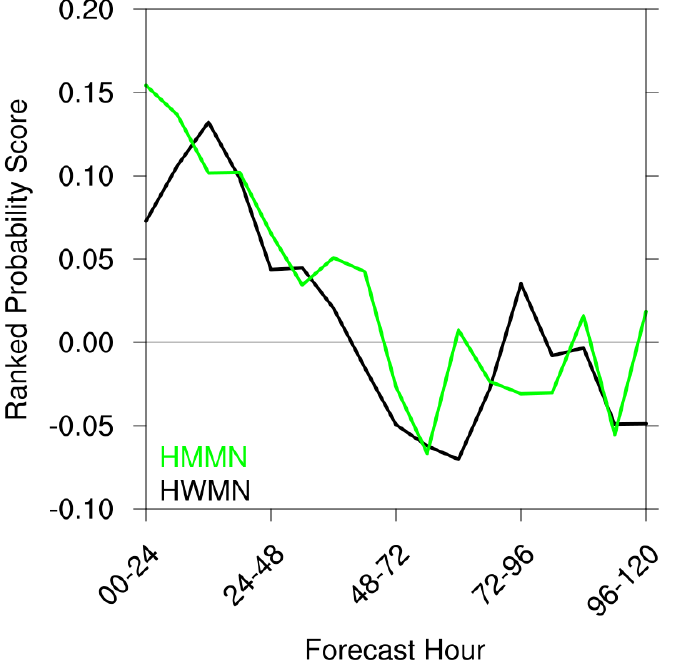
Figure 6. Ranked Probability Skill Score (RPSS) of HWRF and HMON ensemble 24 h maximum wind speed change as a function of forecast lead times from2017 to 2019.